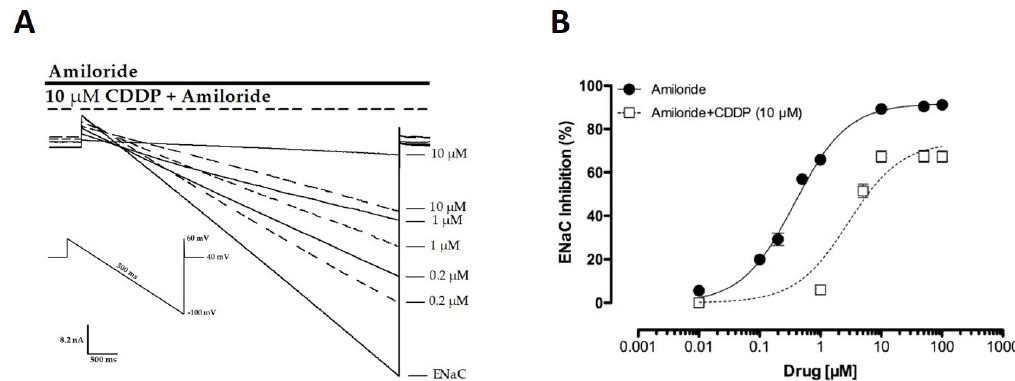
Figure 4. CDDP competes with amiloride, lessening the inhibitory e ff ects of amiloride on ENaC. ( A ) Overlay of typical macroscopic current traces from a representative CHO cell expressing mENaC before and after treatment, with (0.2–10 µ M) amiloride in the presence (dashed lines) and absence (full lines) of 10 µ M of CDDP. Currents elicited by voltage ramps were stepped from a holding potential of 40 mV to 60 mV and ramped to − 100 mV. ( B ) Summary graph of ( n = 3–5 for each amiloride concentration) experiments showing concentration-dependent e ff ects of amiloride on mENaC in the absence (black circles, full line) and presence (white boxes, dashed line) of 10 µ M of CDDP. Exposure to CDDP reduced the maximal inhibition percentage of amiloride and caused a dextral displacement of the amiloride inhibition curve.